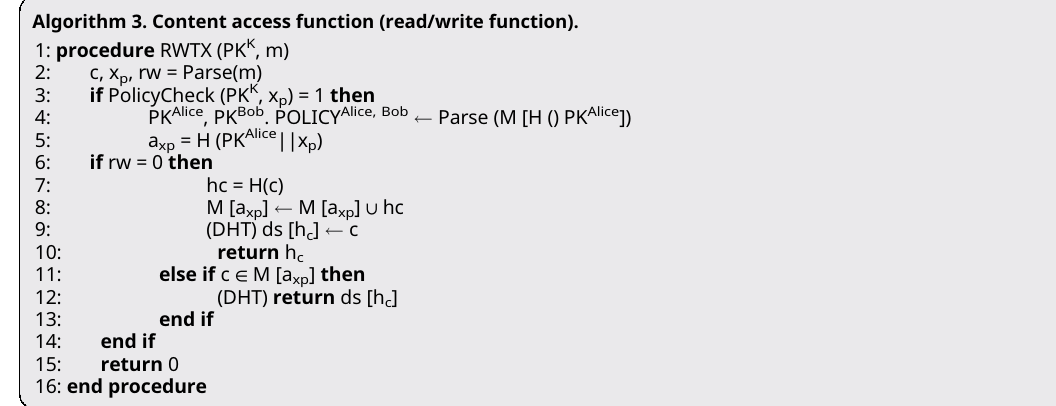
Algorithm 3. Content access function (read/write function).